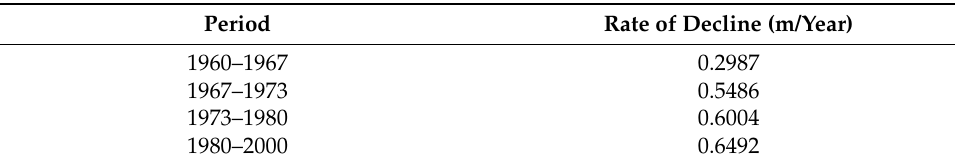
Table 1. Water table decline in the Upper Bari Doab